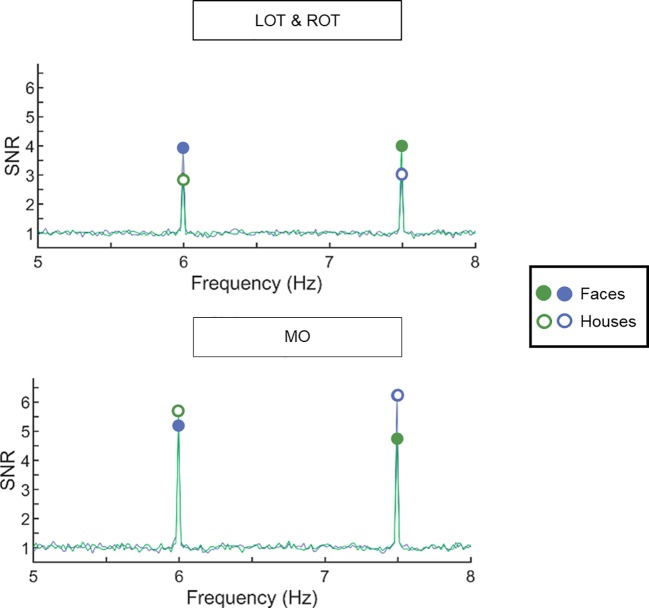
Signal-to-noise ratio (SNR) spectra averaged across all participants (across the two groups) show clear responses at the first harmonic frequencies of interest. Data are plotted for the left and right occipito-temporal region (upper panel) and the medial occipital region (lower panel). The frequency spectrum is plotted from 5 to 8 Hz. In green, images of houses are presented at 6 Hz, while images of faces were presented at 7.5 Hz. In blue, the frequencies were reversed. Full circles display the neural response for faces, empty circles display the neural response for houses. In left and right occipito-temporal ROIs, the response to faces is larger than to houses. In the medial occipital ROI, the response to houses is larger than the response to faces.